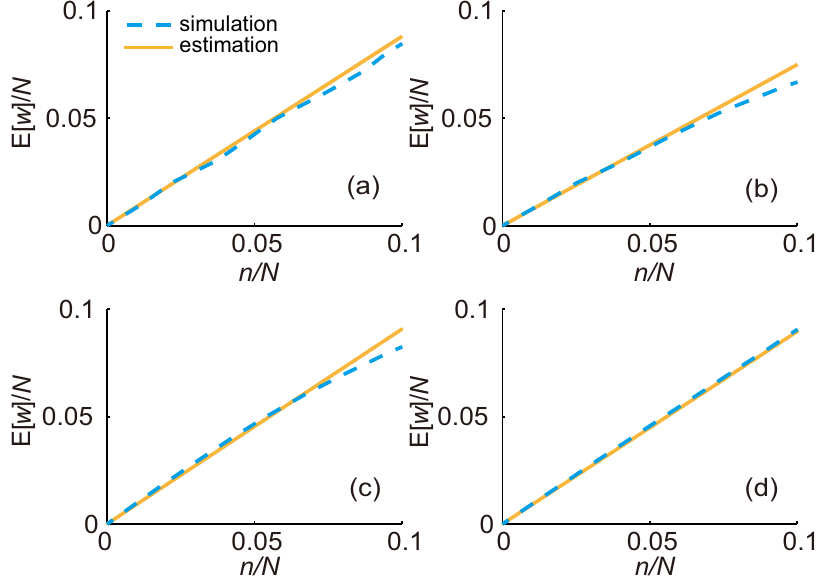
Figure 5. The expectation of the number of immunized nodes E[ w ] from the theoretical estimations and the immunization simulations in ( a ) the Advogato network, ( b ) the Brightkite network, ( c ) the Epinions network and ( d ) the MSM network. The expectation is averaged over 100